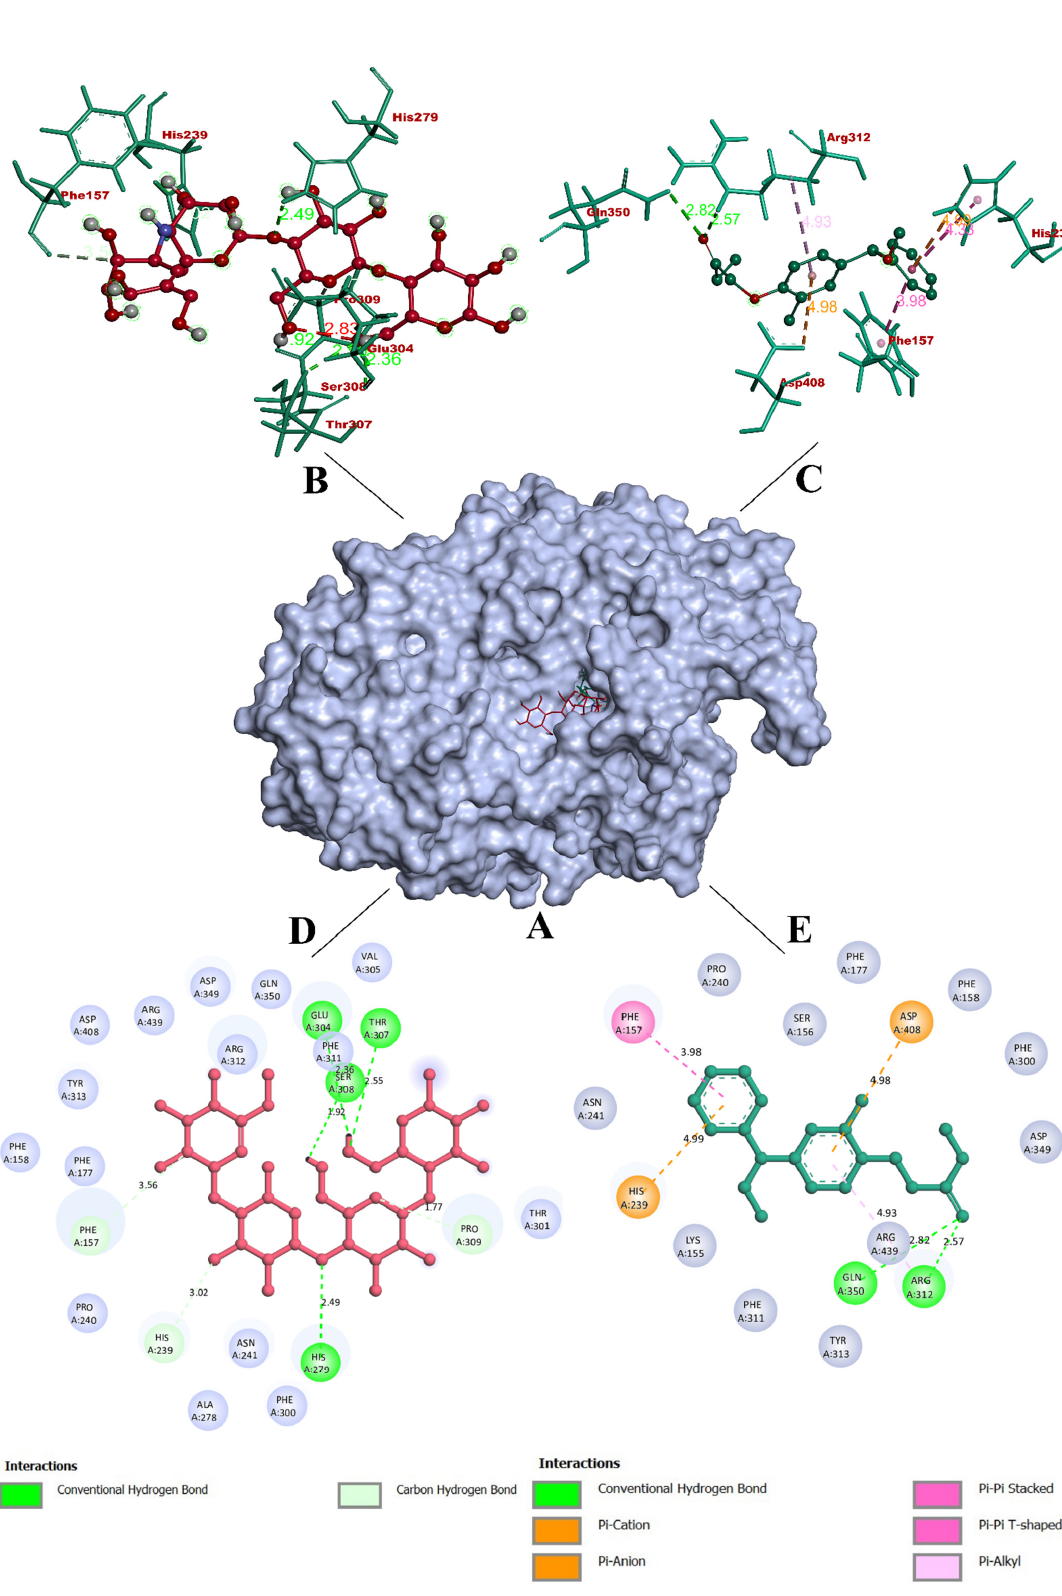
Figure 5. Visualization of binding interactions of the crystal compound and acarbose with the α - glucosidase; ( A ) surface diagram showing bound acarbose (red) and molecule (green); ( B , C ) 3D representation of acarbose (red) and molecule (green), respectively; ( D , E ) 2D representation of acarbose (red) and molecule (green),